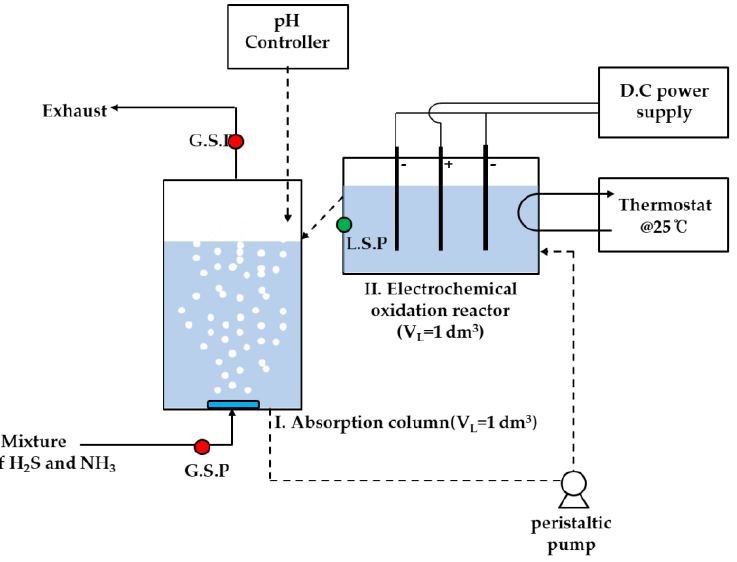
Figure 1. Schematic of the experimental setup (G.S.P is gas sampling port; L.S.P is liquid sampling port; full line indicates gas stream; dotted line indicates liquid